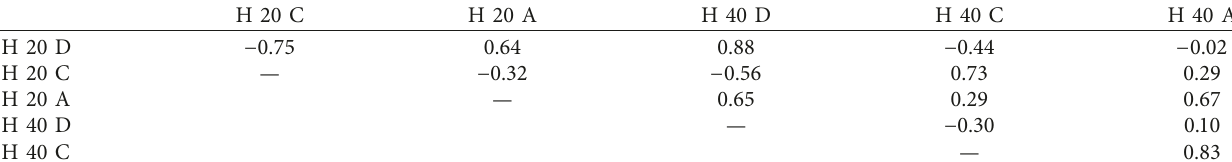
Table 7: Coefficients from Spearman’s rank correlation tests comparing dispersion, closure, and area for 20 and 40dB Z regions in Humberto. H 20 C